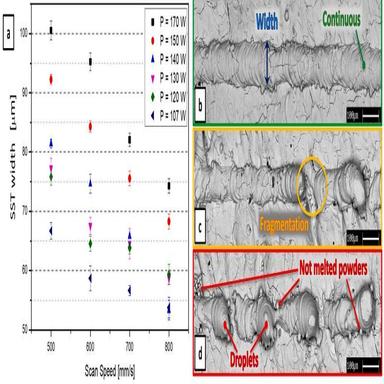
(a) width of SSTs as a function of scan speed for six different laser power measured with the software ImageJ; (b) SEM images of continuous and homogeneous SSTs; (c) fragmented or irregular SSTs; (d) Mo droplet or not melted SSTs.